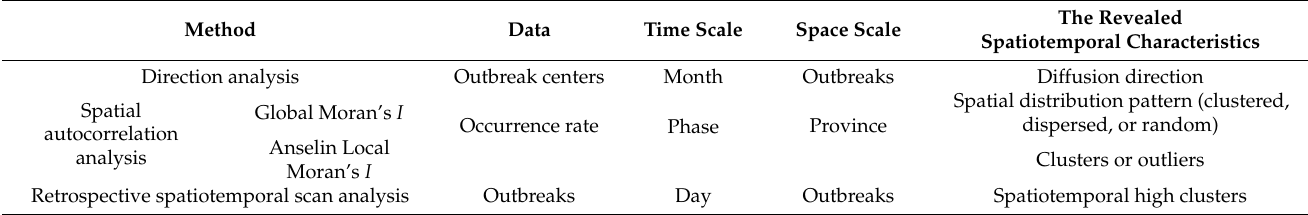
Table 1. The comparison of spatial statistical methods used in this